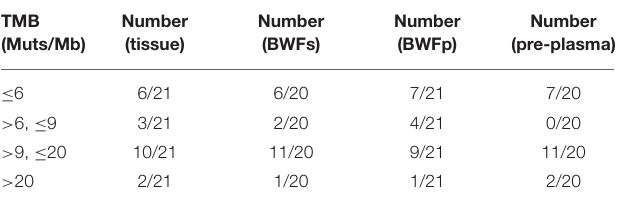
TABLE 2 | The TMB status in the different types of